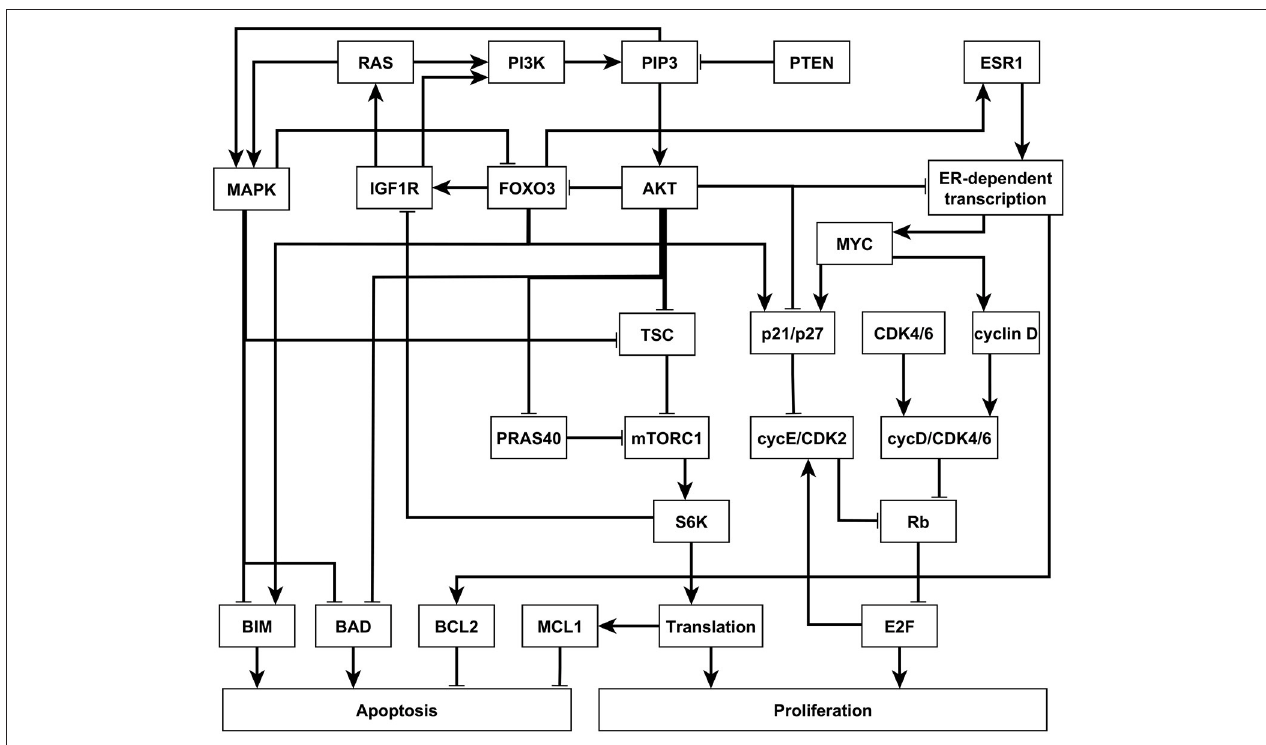
FIGURE 4 | An illustration of the PI3K mutant, ER + breast cancer network. Attractor-preserving network reduction was applied to focus on the nodes most relevant to our analysis. Nodes are colored according to the signaling pathway that they participate in. Edges ending with an arrow represent positive regulation while edges ending with a hollow diamond represent negative regulation. See more details in Supplementary Material section